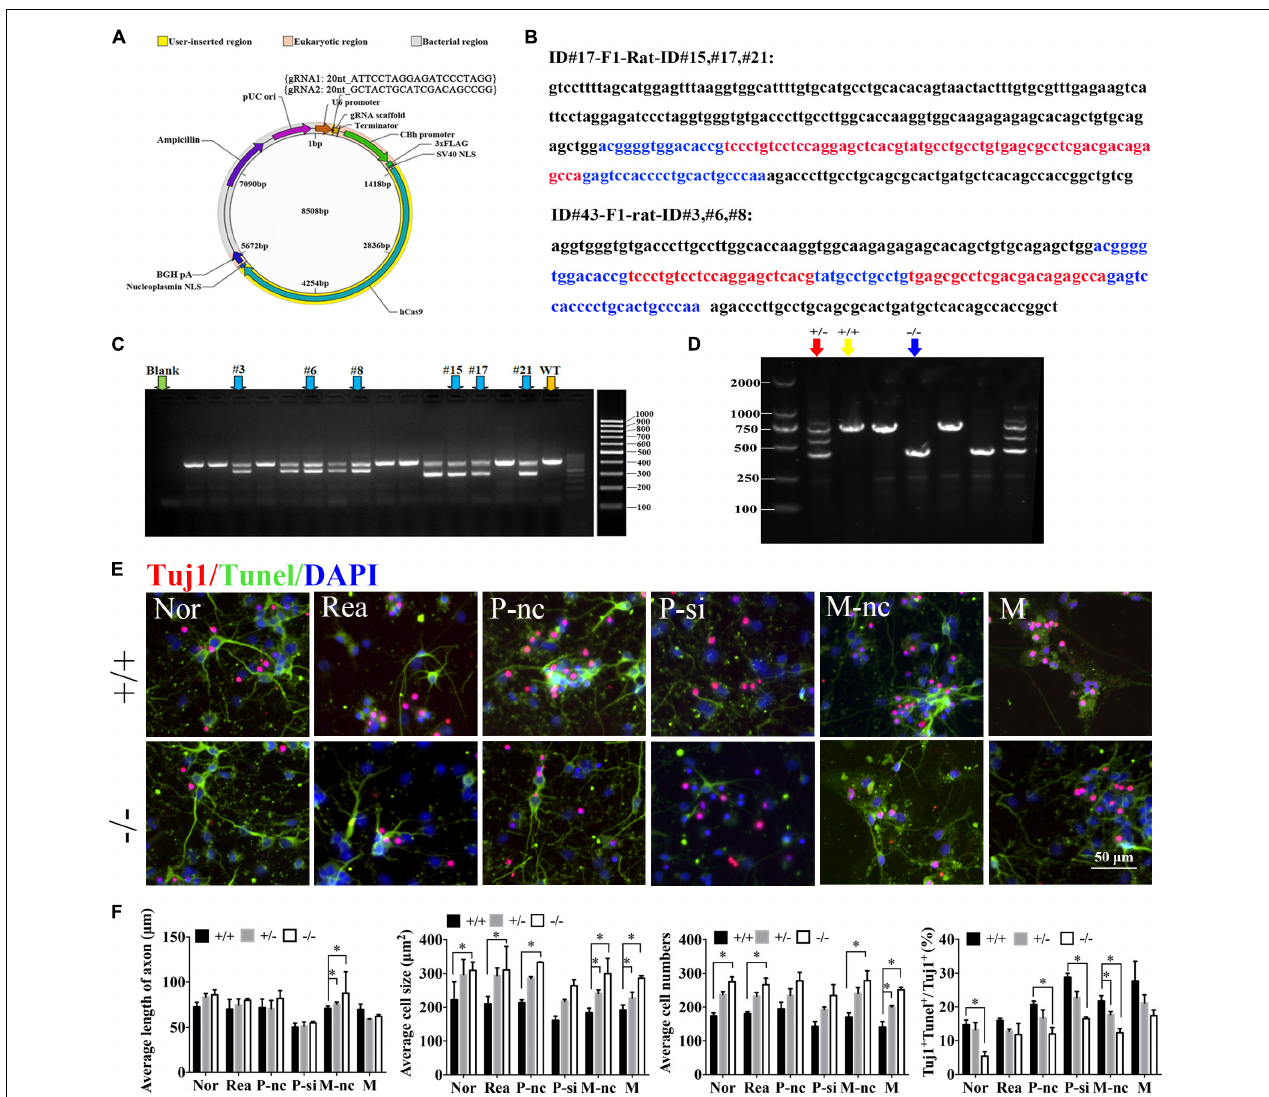
FIGURE 6 | The role of miR-339 and its regulatory relationship with PDXK on neurite growth at miR-339 knockout neurons. (A) The construction of vector. (B) Sequencing results: the deleted sequence is black, and the exon sequence is highlighted in blue and red. (C) F1 founder PCR screening: the molecular weight of the wild-type rats is 729 bp; the missing molecular weight of #15, #17, and #21 is 300 bp; the missing molecular weight of #3, #6, and #8 is 202 bp. (D) Electrophoretic band chart for genotype detection. Red green arrow refers to heterozygote rats, yellow arrow refers to wild-type rats, and blue arrow refers to knockout rats. The markers exhibit 100, 250, 500, 750, 1,000, and 2,000 bp, respectively. ± represents heterozygote rats, +/+ represents wild-type rats, and − / − represents the knockout rats. (E) Photomicrographs of neurons detected by Tuj1 staining in Nor, Rea, P-nc, P-si, M-nc and M groups of − / − and +/+ neurons. DAPI counterstaining (blue) demonstrated nuclei of intact cells, and red fluorescence represented Tuj1 positive staining. Apoptotic neurons were determined by Tuj1 and TUNEL staining, presented by Tuj1 + Tunel +/Tuj1 + (%) in Nor, Rea, P-nc, P-si, M-nc and M groups of − / − and +/+ neurons. DAPI counterstaining (blue) demonstrated nuclei of intact cells, red fluorescence represented Tuj1, and red fluorescence represented apoptosis. Scale bar = 50 µ m. (F) The length of axon, cell size, cell numbers and apoptosis rate in Nor, Rea, P-nc, P-si, M-nc and M groups of − / − , +/ − and +/+ neurons. DAPI counterstaining (blue) demonstrated nuclei of intact cells, red fluorescence represented Tuj1, and red fluorescence represented apoptosis. Scale bar = 50 µ m. Data were exhibited as mean ± SD. * p < 0.05 vs. +/+, # p < 0.05 vs. P-nc. Nor, normal; Rea, reagent; P-nc, PDXK-nc; P-si, PDXK-si; M-nc, miR-339-mimic-nc; M, miR-339-mimic; WT, wild type; NC, negative control. − / − represents miR-339 knockout homozygote. +/+ represents wild type. ± represents heterozygote. TUNEL, terminal deoxyribonucleotidyl transferase-mediated dUTP-digoxigenin nick-end labeling; DAPI,